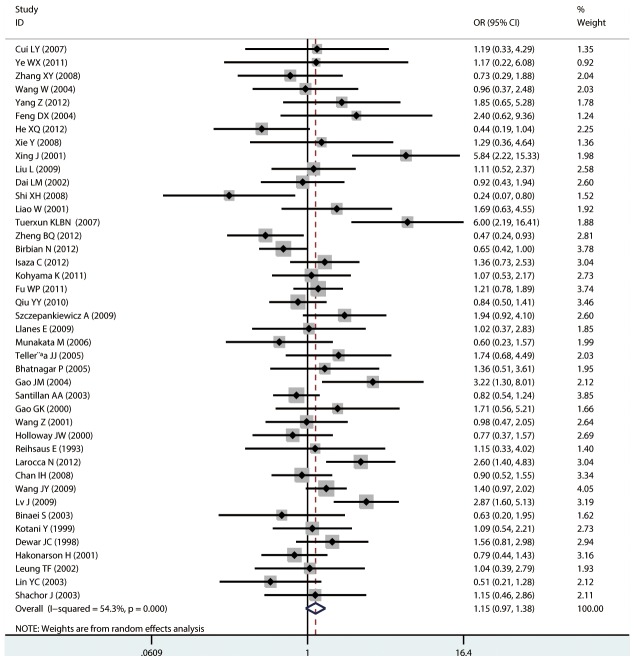
Forest plots of the association between the Arg16Gly (rs1042713) polymorphism and risk of asthma in homozygote genotype comparison.